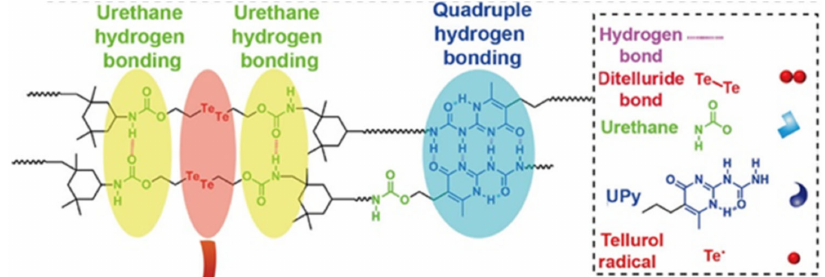
Figure 43. Proposed interactions formed between the macromolecule chains. Reprinted with permission from [203]. Copyright (2020) American Chemical